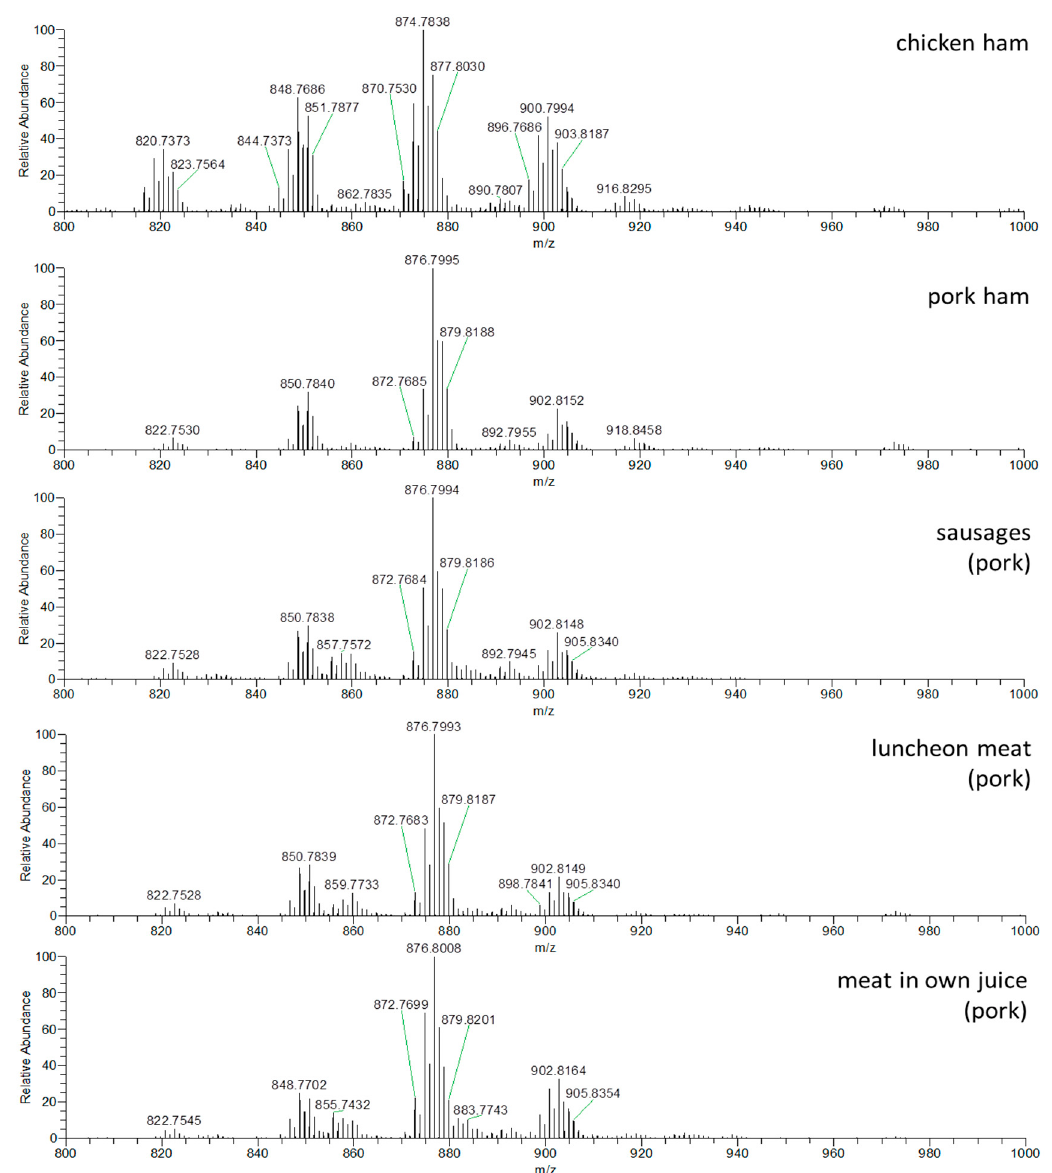
Figure 3. DART–HRMS profiles of triacylglycerol and hexane extracts of chicken ham, pork ham, sausages, luncheon meat and meat in natural juices, m / z range 800–1000, positive ionization.